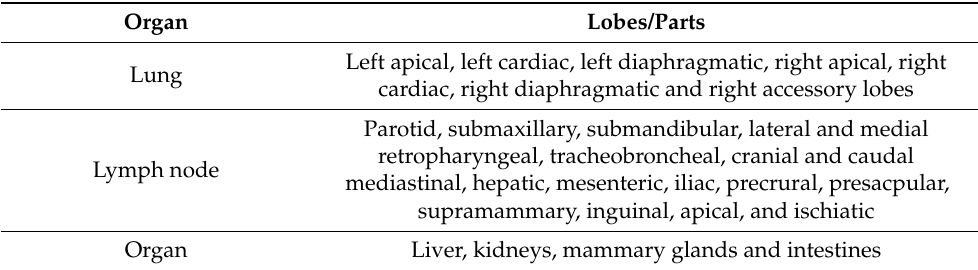
Table 1. Anatomical location of lymph nodes in different parts of the